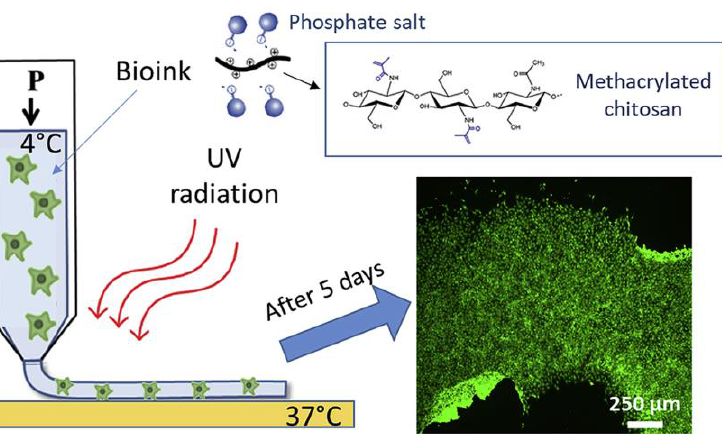
Figure 9. Dual-crosslinked hydrogel bioink using chitosan methacrylate together with β -glycerol phosphate with NIH 3T3 cells. Reprinted from [24], Copyright 2020, Elsevier.